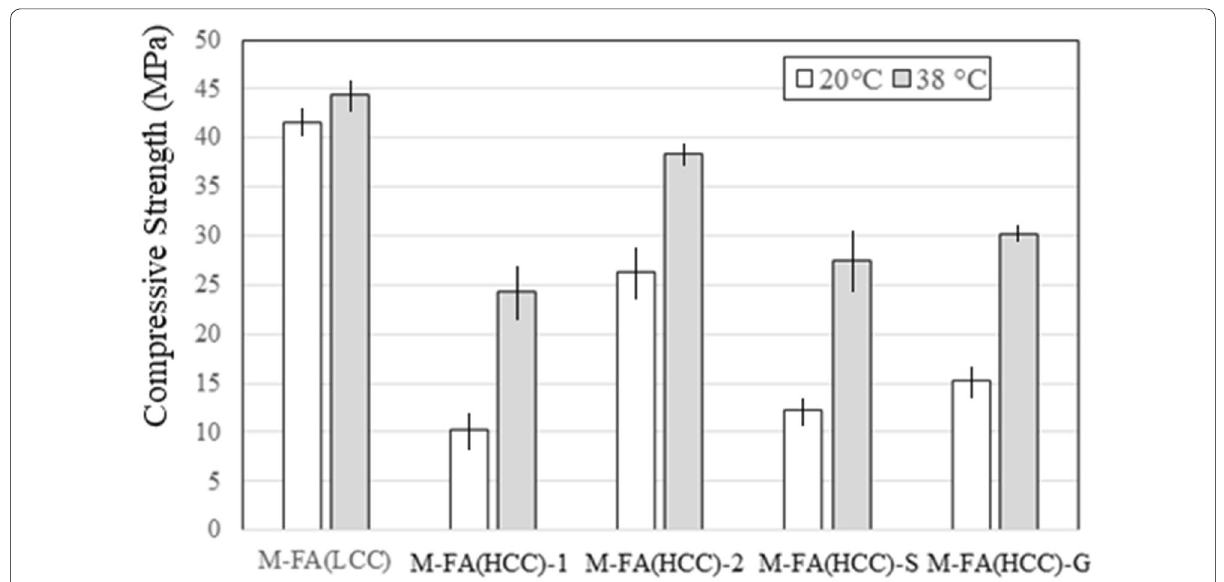
Fig. 5 Mechanical properties of the investigated materials cured at different